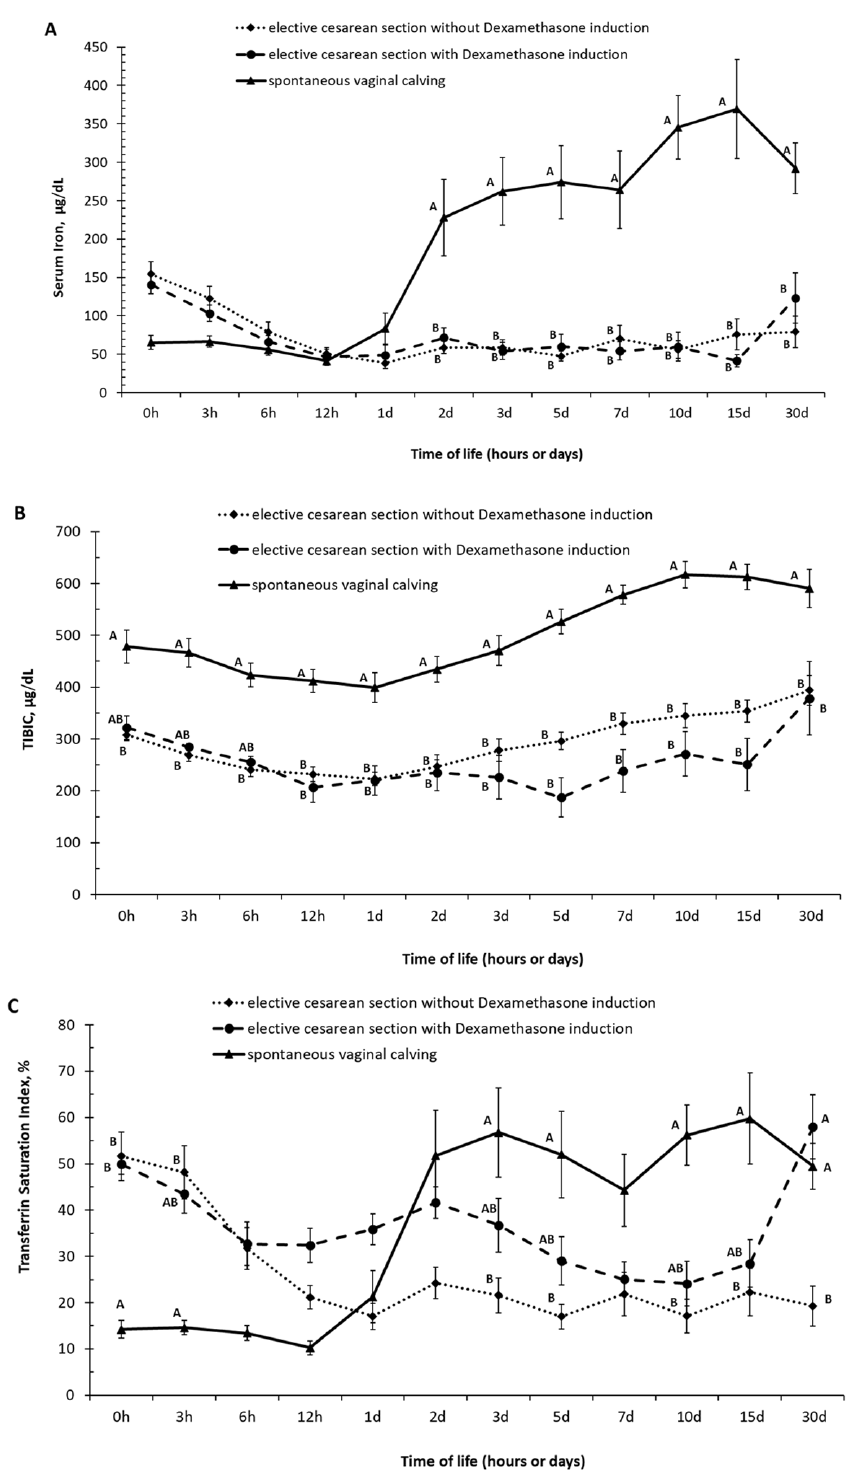
Figure 2. ( A ) Serum iron, ( B ) total capacity to bind iron to transferrin—TIBIC, ( C ) transferin saturation index—(TSI, (means ± SEM) in calves born by spontaneous vaginal calving ( n = 10) and elective cesarean calving with ( n = 14) or without ( n = 14) induction during the first month of life. A, B, C—Different letters on the line mean statistically significant difference compared with Tukey’s teste, at 5%